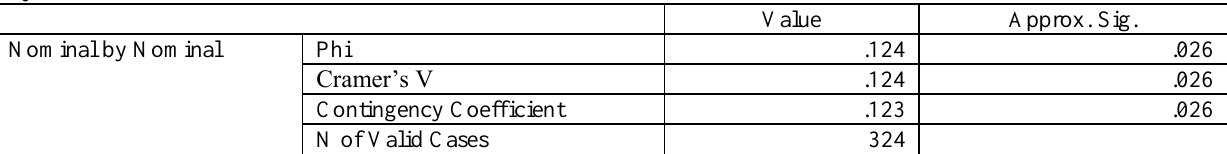
Table 4b: Respondents’ satisfaction with the airlines’ service and whether they have formed a long-term relationship with the